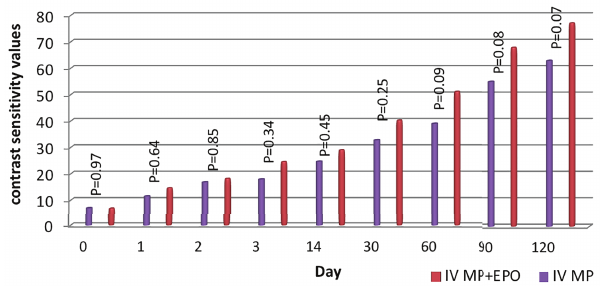
Figure 2. Comparison of contrast sensitivity in patients with retrobulbar optic neuritis in the two treatment groups. IV MP, intravenous methylprednisolone; IV MP + EPO, intravenous methylprednisolone in combination with intravenous erythro-